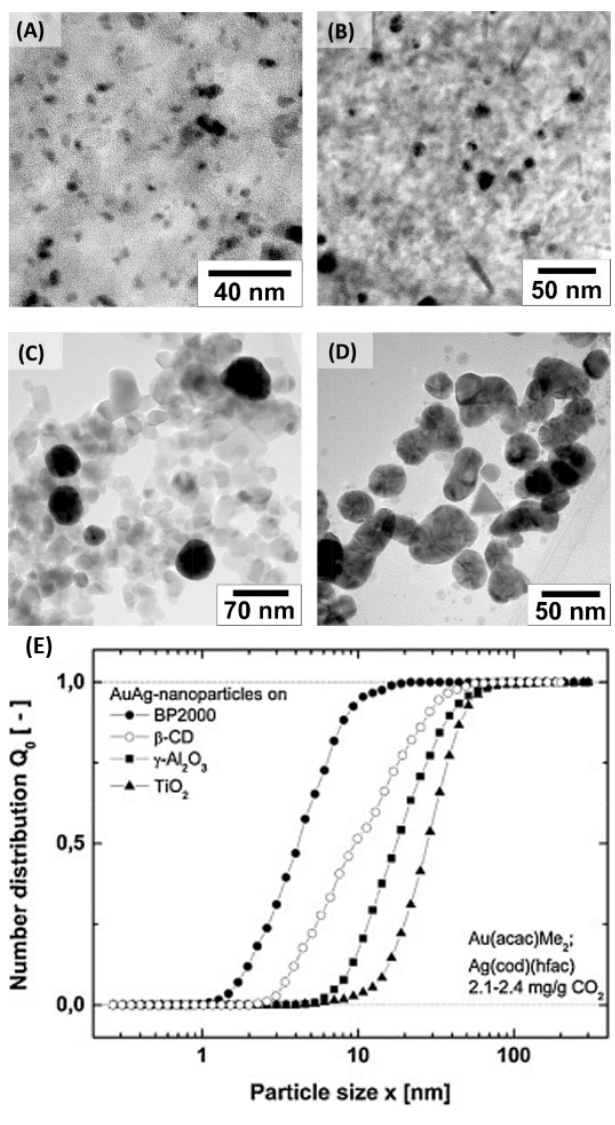
Figure 7. TEM images from Au ‐ Ag NPs deposited on BP2000 ( A ), γ‐ Al 2 O 3 ( B ), TiO 2 ( C ), and β‐ CD ( D ) by SFRD at 353 K and 15.5 MPa, ( E ) particle size distribution of Au ‐ Ag NPs deposited on BP2000, γ‐ Al 2 O 3 , TiO 2 , and β‐ CD by SFRD at 80 °C and 155 bar CO 2 . Reprinted with permission from reference